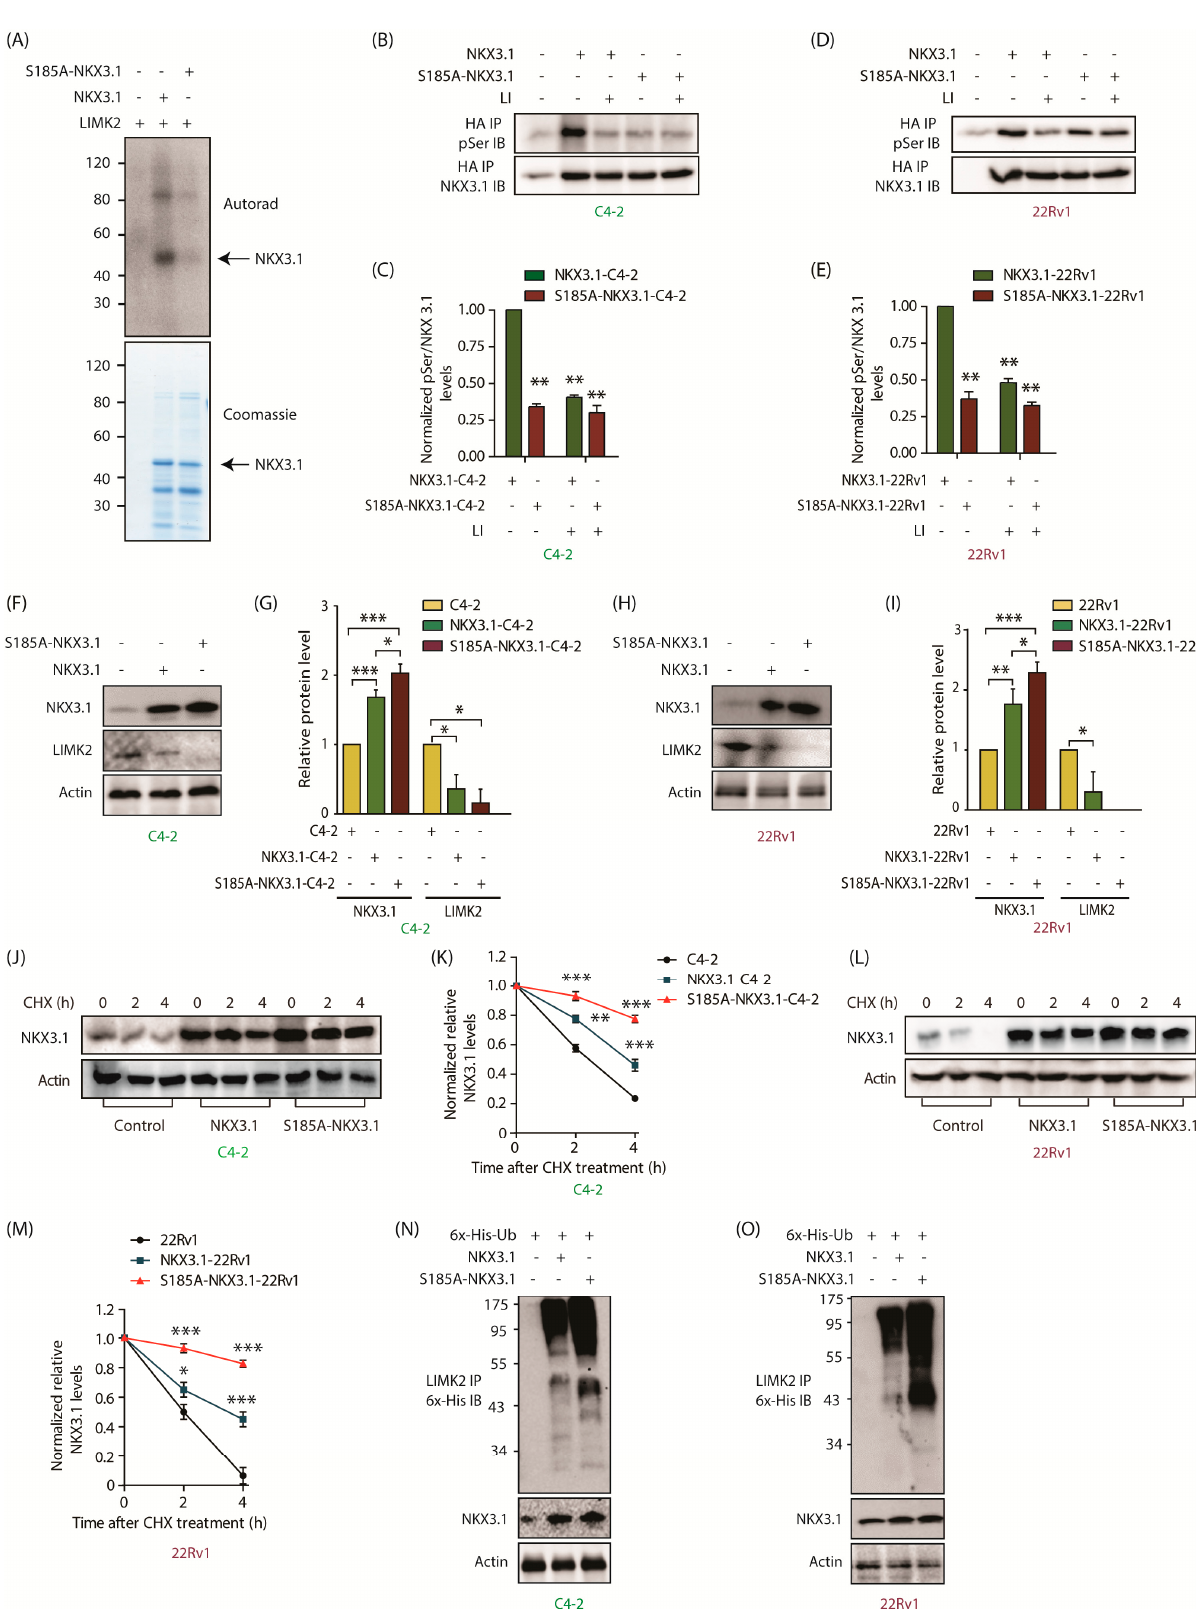
Figure 4. LIMK2 modulates NKX3.1 stability via direct phosphorylation at S185. ( A ) LIMK2 phosphorylates wild-type NKX3.1 but not S185A mutant. In vitro phosphorylation assay was performed using LIMK2, wild type NKX3.1, and S185A-NKX3.1. The top panel represents an autoradiograph, whereas the bottom panel shows the corresponding gel